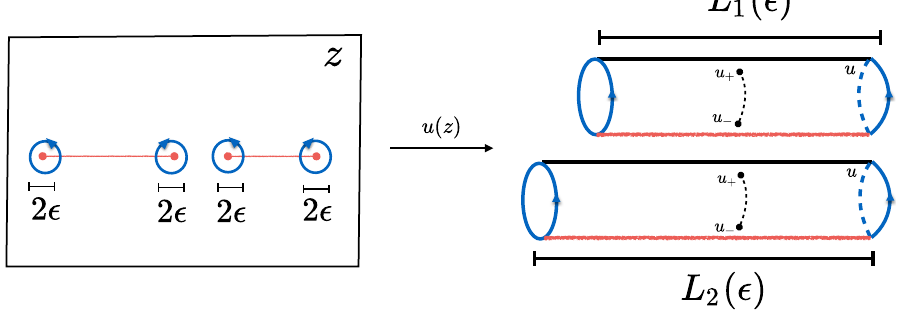
Figure 8 . The regulated z plane is mapped to a two sheeted cover of the cylinder, with slightly di(cid:11)erent lengths L 1 ( (cid:15) ) and L 2 ( (cid:15) ). The total length of the two sheeted cylinder is proportional to the entanglement